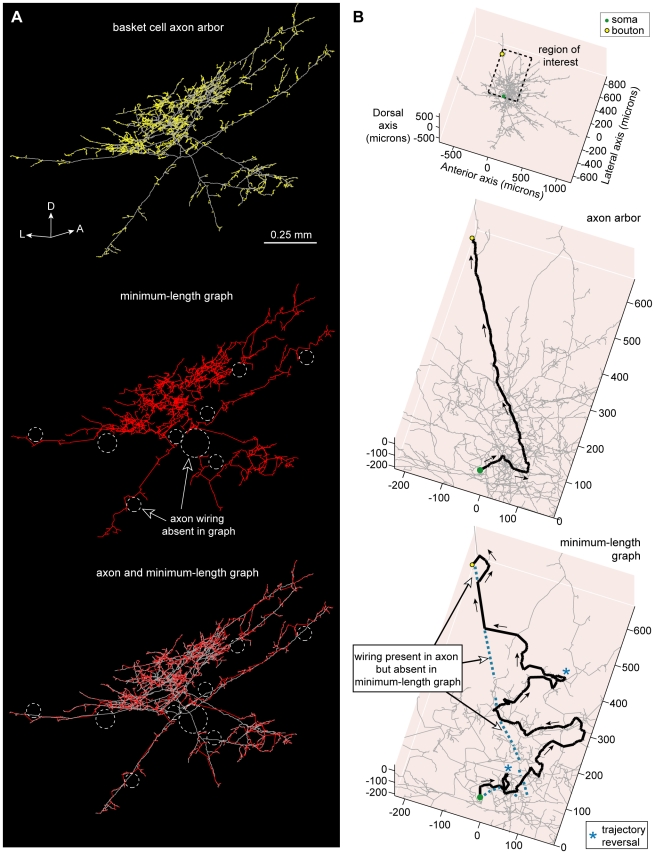
Basket cell axon arbor wiring compared with minimum-length tree.(A) Example putative inhibitory large basket cell axon arbor (coronal view) showing bouton locations (upper), its Minimum Spanning Tree (MST) graph (middle), and overlay of axon arbor and graph (lower) demonstrating different wiring patterns used to connect same bouton set as shown by dotted circles (white). (Key: axon  =  grey lines, graph  =  red lines, boutons  =  yellow dots; anatomical axes: A, anterior; D, dorsal; L, lateral; P, posterior). (B) Example of the shortest path from axon origin (root vertex) of this neuron to a selected bouton (upper, see region of interest) for the biological arbor (middle) was initially directed away from the bouton but virtually direct thereafter (0.87 mm path length) yet for the length-minimized tree (lower) the course was tortuous (2.28 mm path length), including two trajectory reversals (see blue asterisk), because the artificial arbor lacked wire present in axon arbor (dotted blue lines). Arrows show direction of flow from axon origin to bouton. (Key: shortest path  =  thick black lines, unvisited arbor wiring  =  grey lines, axon wiring absent in graph  =  dotted blue lines.).